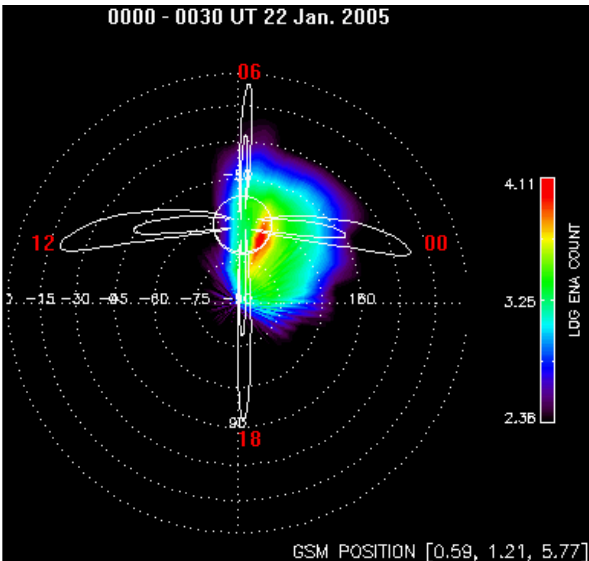
Fig. 8. The optimal recovered ENA image displayed in the same format used in the left panel of Fig.